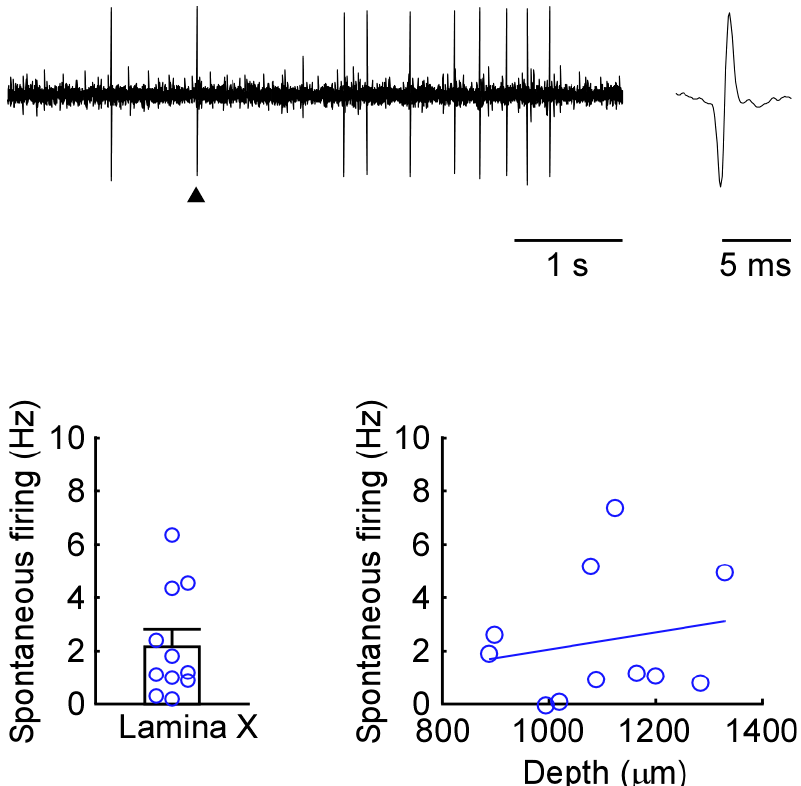
Figure 2. In vivo extracellular recording from lamina X neurons in the rat spinal cord. Representative trace of spontaneous firing recorded from a lamina X neuron (upper panel). The spike shape of an action potential, indicated by an arrowhead, is enlarged on the right side of the trace. Summary showing the frequency of spontaneous firing (lower panel; left) and correlations between the frequency and recording depth in the spontaneous firing (lower panel; right).